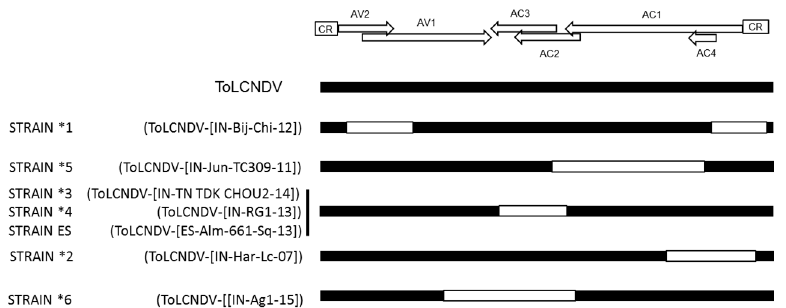
Figure 3. Putative recombination events of isolates of ToLCNDV, representative of different strains. Schematic representation of the putative recombination events present in the DNA-A of isolates of tomato leaf curl New Delhi virus (ToLCNDV) that differ with reported ones at the strain threshold level compared to ToLCNDV-type isolates and deduced based on the results from recombination detection software program (RDP4; Version 4.0, http://web.cbio.uct.ac.za/~darren/rdp.html). Black color indicates ToLCNDV-derived sequences; white color indicates sequences derived from other begomovirus species (adapted and actualized from Fortes et al.